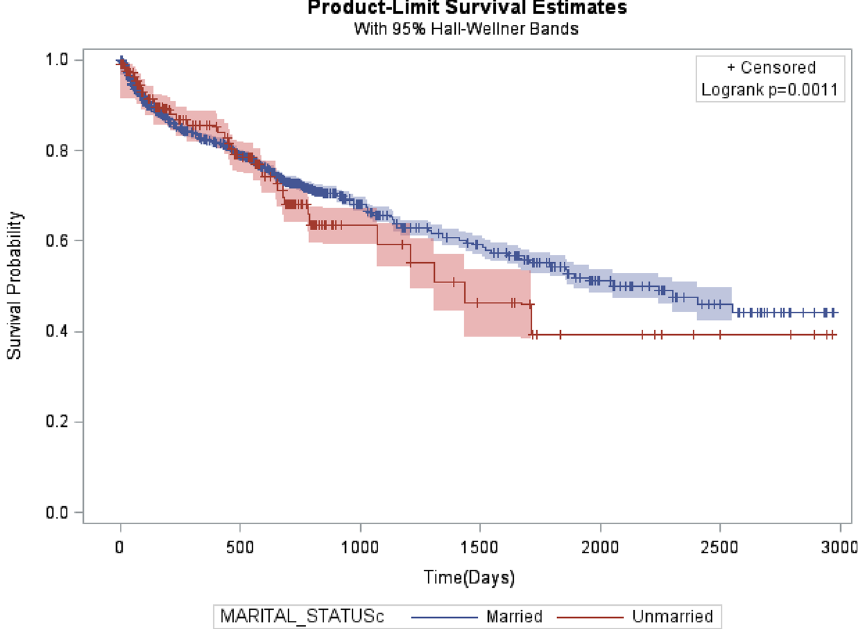
Figure 2. Kaplan–Meier cancer-specific survival curves comparing colorectal cancer by marital